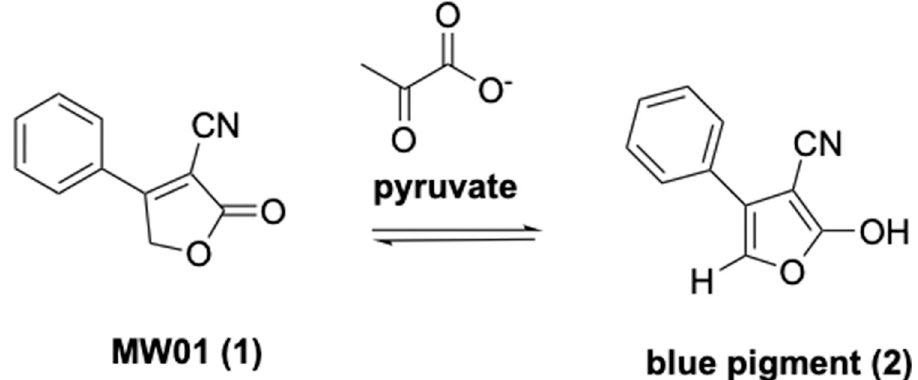
Fig 8. Proposed scheme showing the catalytic role of pyruvate in the reaction with MW01 (1). Only in the presence of pyruvate does the methylene ( δ 5.71, 2H, s) undergo abstraction resulting in proposed blue pigment 2 .